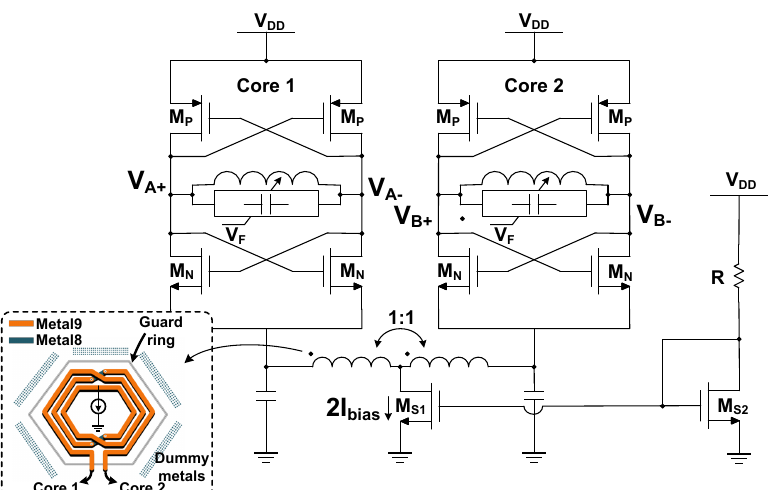
Figure 4. A schematic representation of the super-harmonic coupled quadrature LC-tank VCO